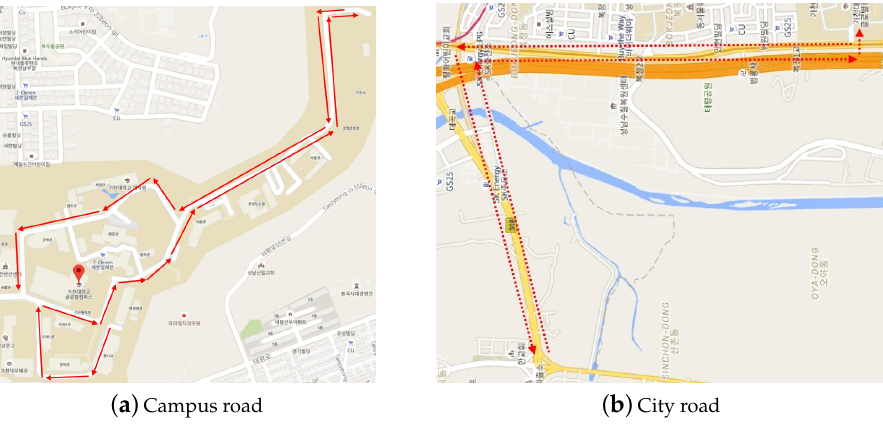
Figure 6. Campus and city routes for measurement.